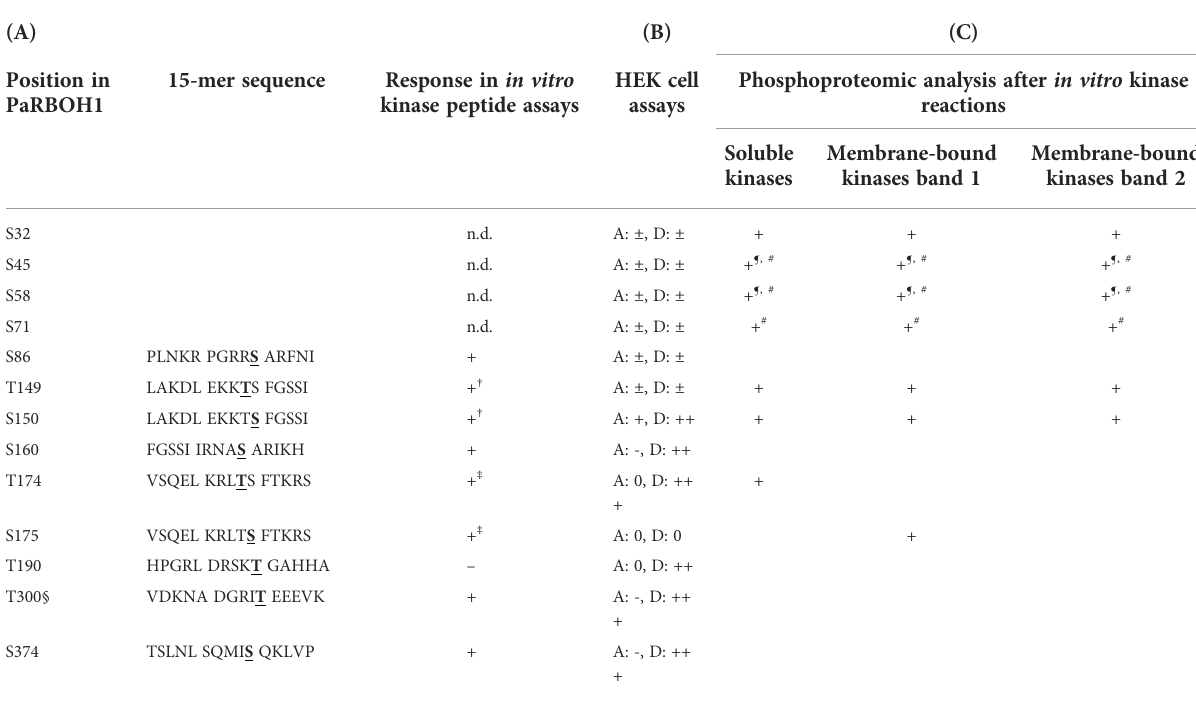
TABLE 1 Phosphorylation of the PaRBOH1 N-terminal serine (S) and threonine (T) residues in in vitro kinase assays with short peptides and the full N-terminus, and the effect of phosphorylation of these residues on the enzymatic activity in HEK cell assays.